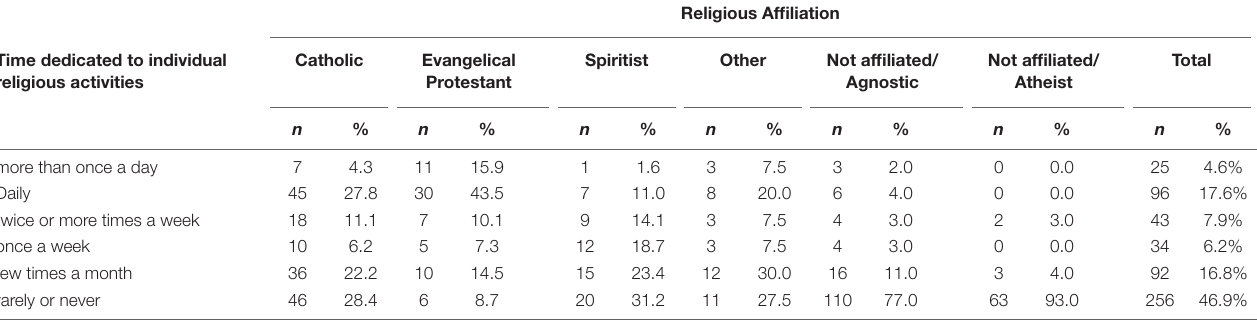
TABLE 6 | Students’ Intrinsic Religiosity per undergraduate